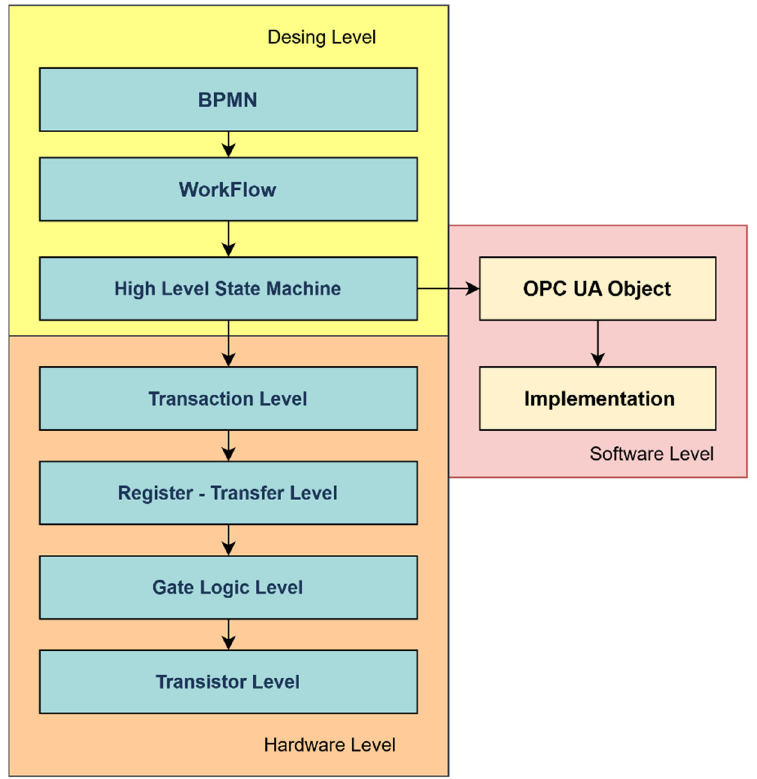
Figure 14. A procedure of an IIoT device design.